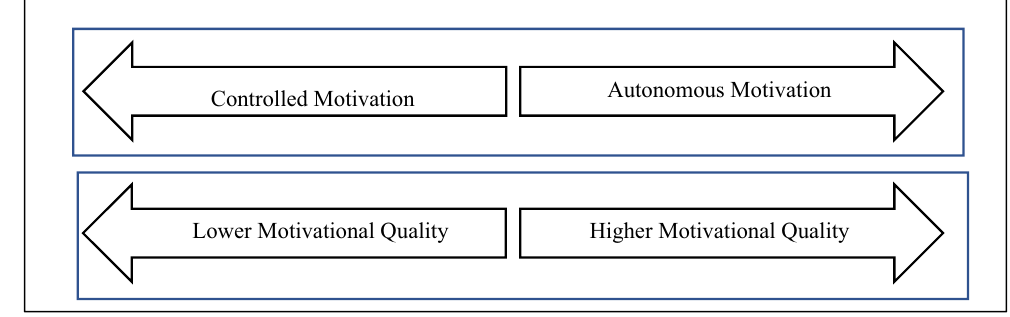
Figure 1. Adapted from SDT continuum: controlled motivation and autonomous motivation in motivational quality 43